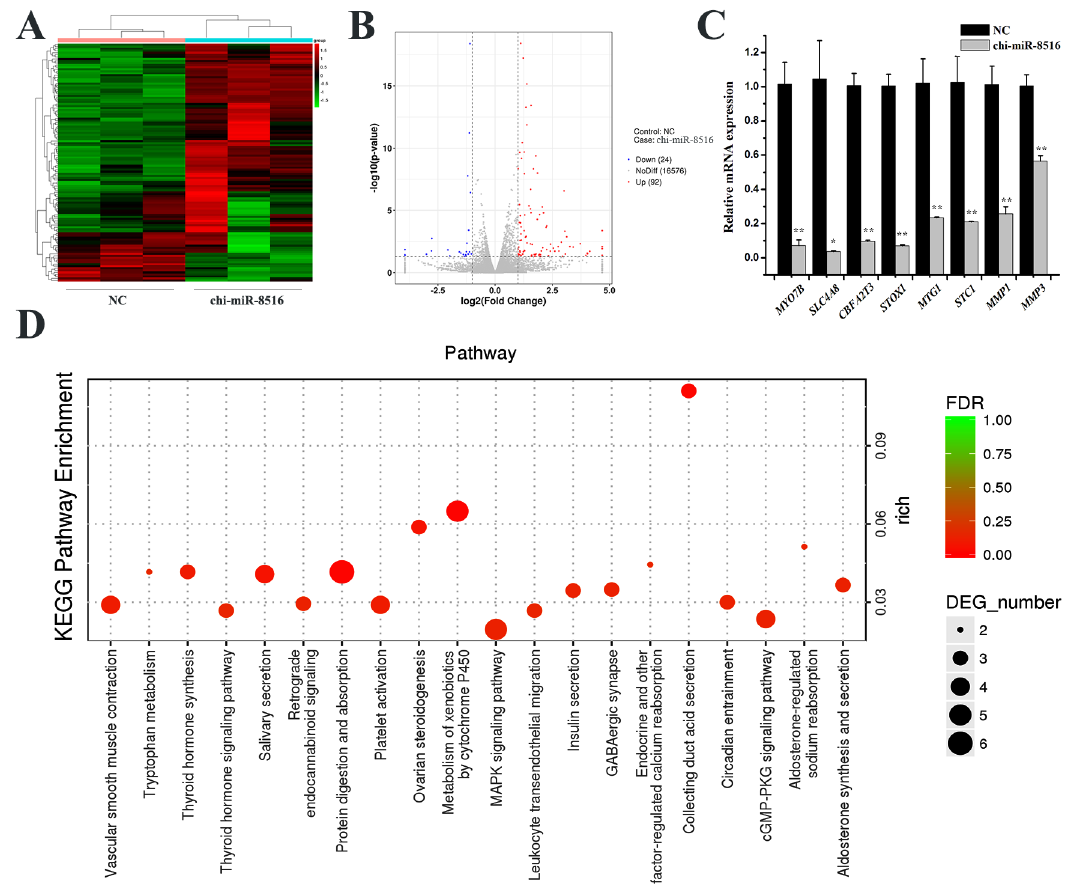
Figure 1. Screening and analysis of DEGs downstream of chi-miR-8516 in GMEC. ( A ) Heat map of each sample transfected with NC or chi-miR-8516; ( B ) DEGs distribution map of chi-miR-8516 in the volcano plot; ( C ) RT-qPCR validation of RNA sequencing results; ( D ) the top 20 KEGG pathways enriched by DEGs. * p < 0.05; ** p <